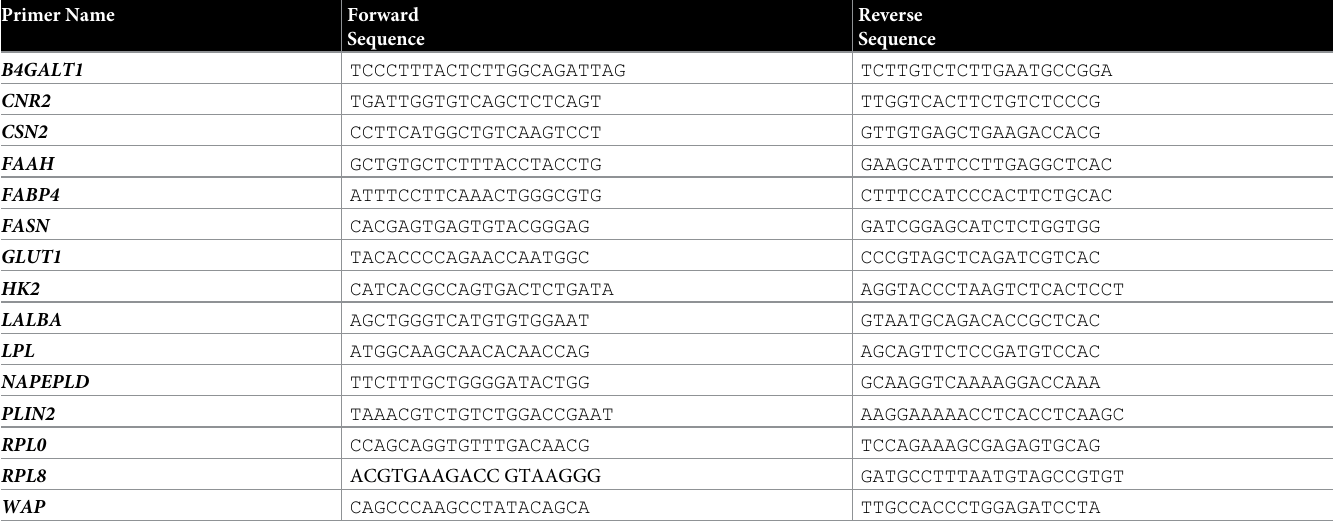
Table 1. Primer sequences of all the genes investigated in this